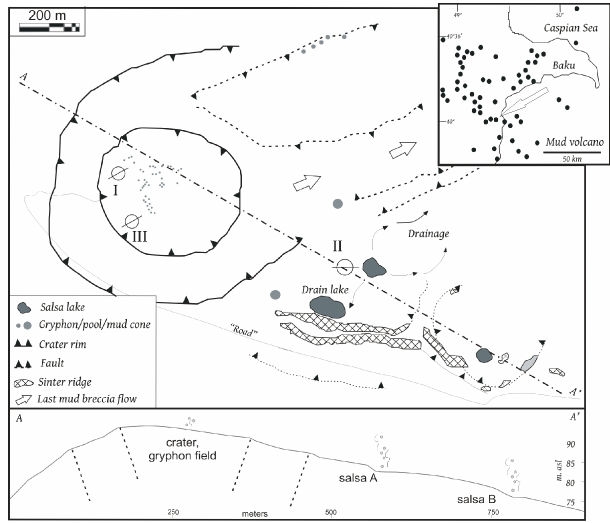
Fig. 1. Simplified map of the Dashgil mud volcano crater field (modified from Mazzini et al., 2009) whose geographic position is shown by the arrow in the inset in the upper right corner (north is upward). Circles indicate positions of ambient vibration measure- ments carried out in 2006 (I, II) and 2007 (III). Bars inside the cir- cles indicate the reference direction for the 3-D seismometer used for ground vibration monitoring. Arrows indicate the direction of the mud flow. Dashed-dotted A-A 0 line indicates the trace of the section in the inset at the bottom of the